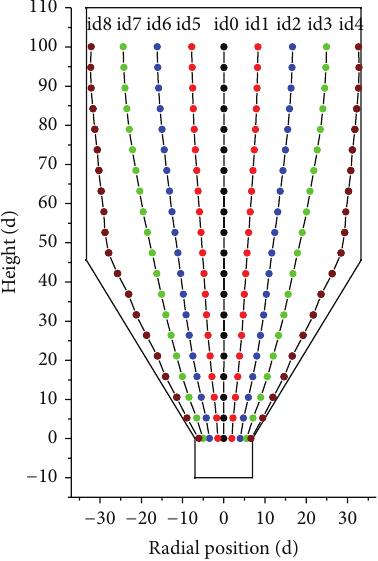
Figure 5: Distribution of the mean stagnant time and the streamline of the marking pebbles in the experiment ( ℎ = 75